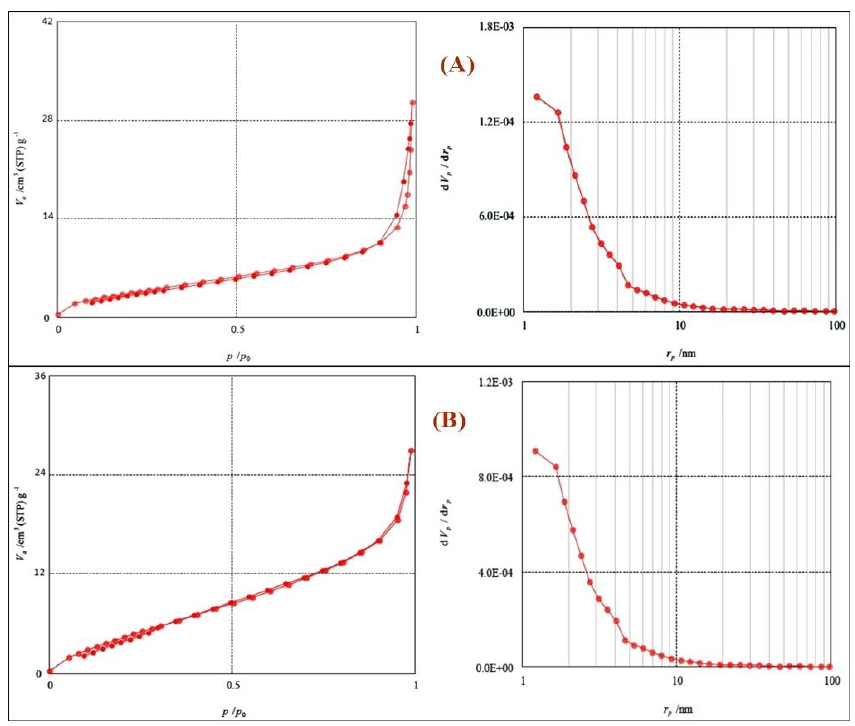
Figure 5. Adsorption–desorption isotherm and Barrett, Joyner, and Halenda (BJH) plot of CPS-3 ( A ) and CPS-2 ( B ).